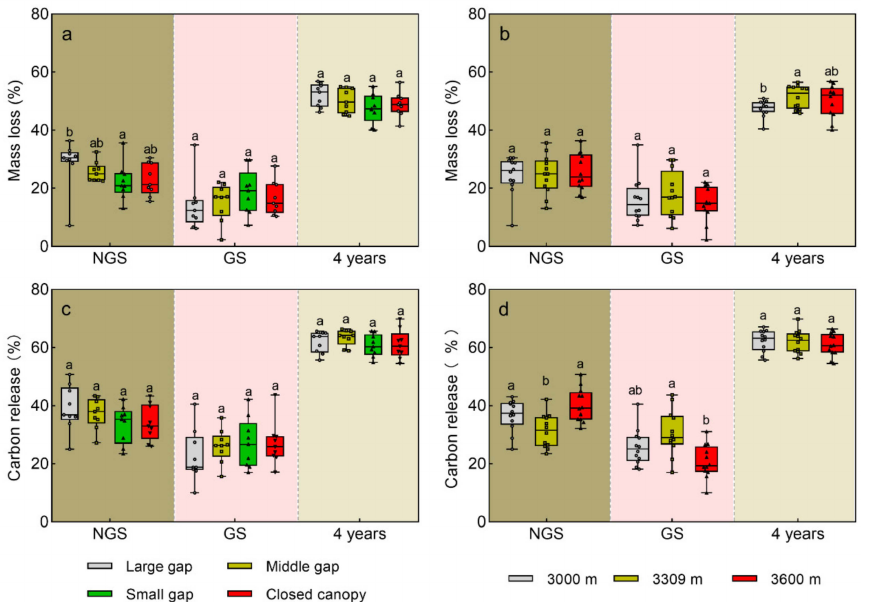
Figure 1. Mass loss and decomposition constant ( k ) of A. faxoniana litter in forest gaps (large gap, middle gap, small gap, closed canopy) along an elevation gradient (3000, 3300, 3600 m) at different decomposition stages in a subalpine forest of southwestern China. ( a ) Mass loss at 3000 m; ( b ) Mass loss at 3300 m; ( c ) Mass loss at 3600 m; ( d ) Decomposition constant k. Mean ± SE, n = 3. OF, onset of freezing stage; DF, deep freezing stage; TS, thawing stage; EGS, early snow-free stage; MGS, middle snow-free stage; LGS, late snow-free stage; NGS, non-growing season; GS, growing season. Asterisk above lines indicates significant differences among forest gaps ( p < 0.05), lowercase letters above columns indicate significant differences among forest gaps ( p < 0.05), capital letters above columns indicate significant differences among elevations ( p < 0.05).